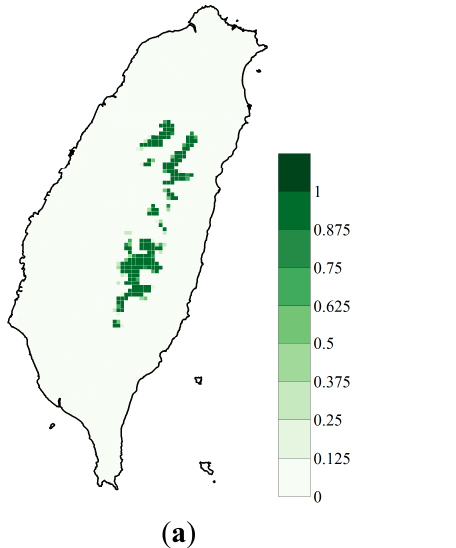
Figure 6. The proportion of habitat in 1000 realizations (local uncertainty) under the baseline scenario for: ( a ) Abies ; ( b ) Tsuga